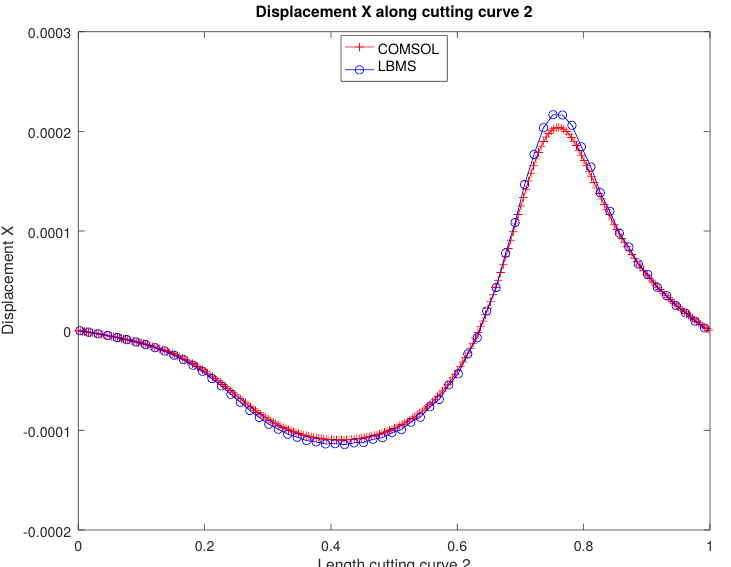
Figure 7. The first displacement component along cutting curve C 2 for case E = 200 GPa, ν = 0.15 with triangular